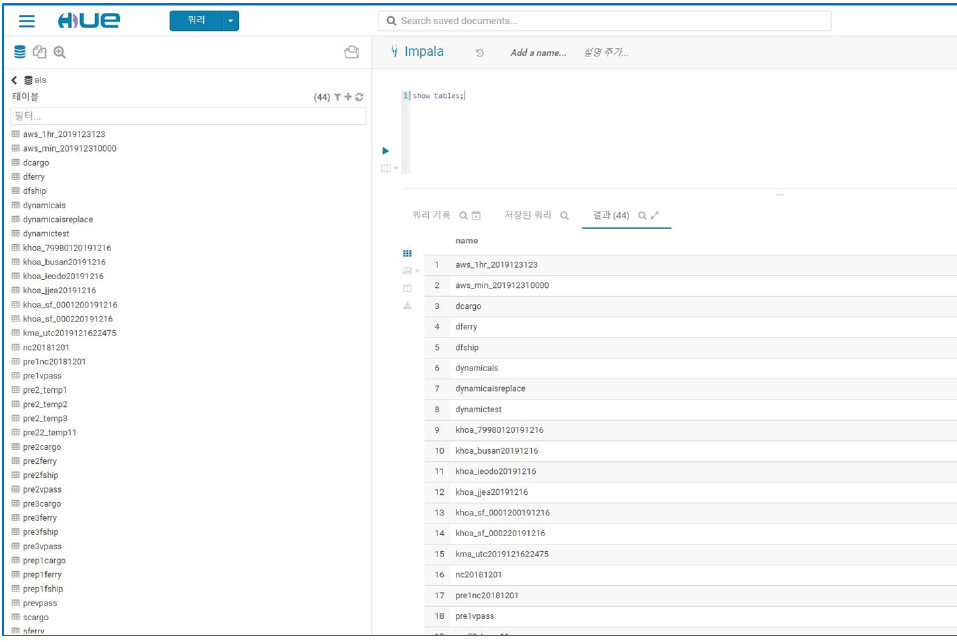
Figure 6. Data Lakehouse tables for AIS, V-Pass, VBD, and Observation data.